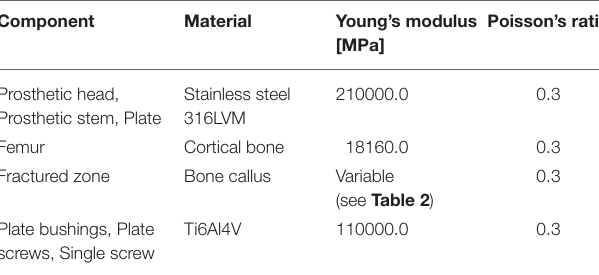
FIGURE 5 | Numbering assigned to holes and zones of the plate (Left) ; lateral (Middle) ; and postero-anterior (Right) views of plate and bone callus volume. The longitudinal extension of the fracture is pointed out, as well as the fracture bone callus average thickness. TABLE 1 | Materials assigned to the model components and mechanical characteristics assumed ( Srivastav, 2011).